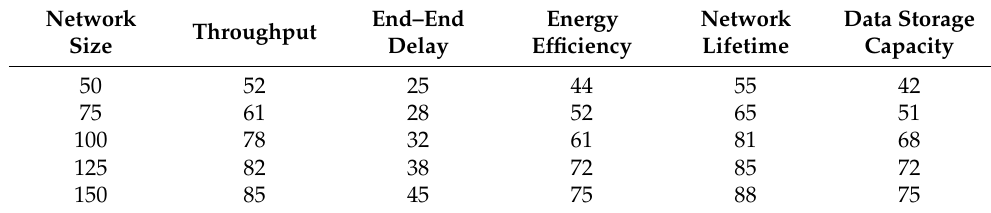
Table 7. Overall comparisons of MLRP-HTEEN-UDSP.